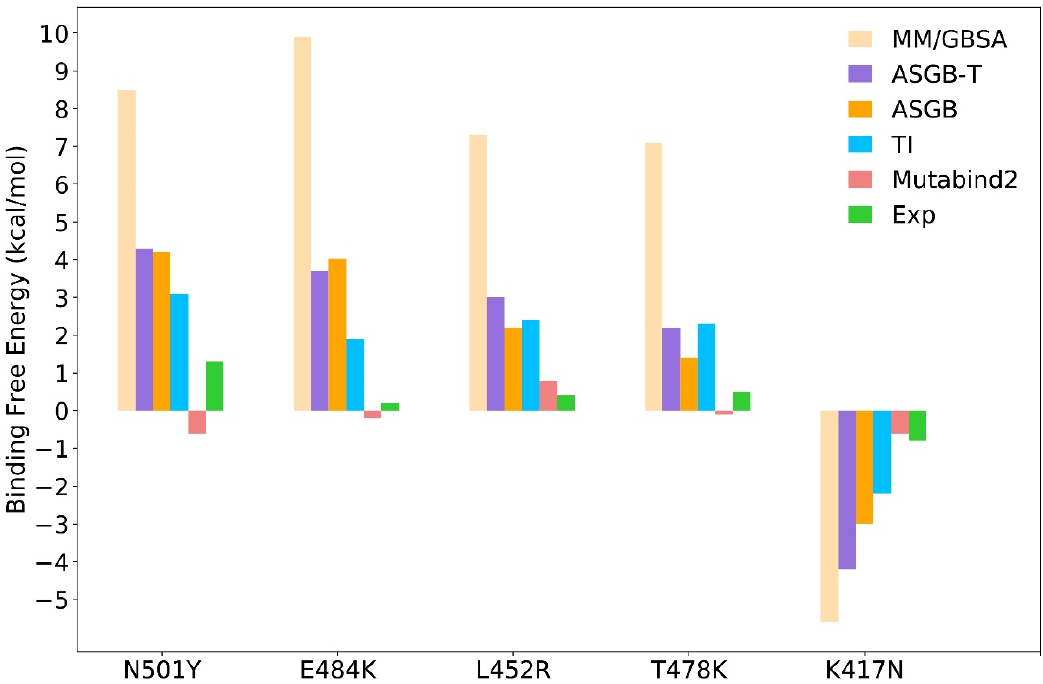
Figure 3. Computational results of these five mutations (N501Y, E484K, L452R, T478K and K417N) by using different methods. The yellow, purple, orange, blue, red and green bars represent the MM/GBSA method, ASGB-T method, ASGB method, TI method, Mutabind2 method and experi- mental results, respectively.